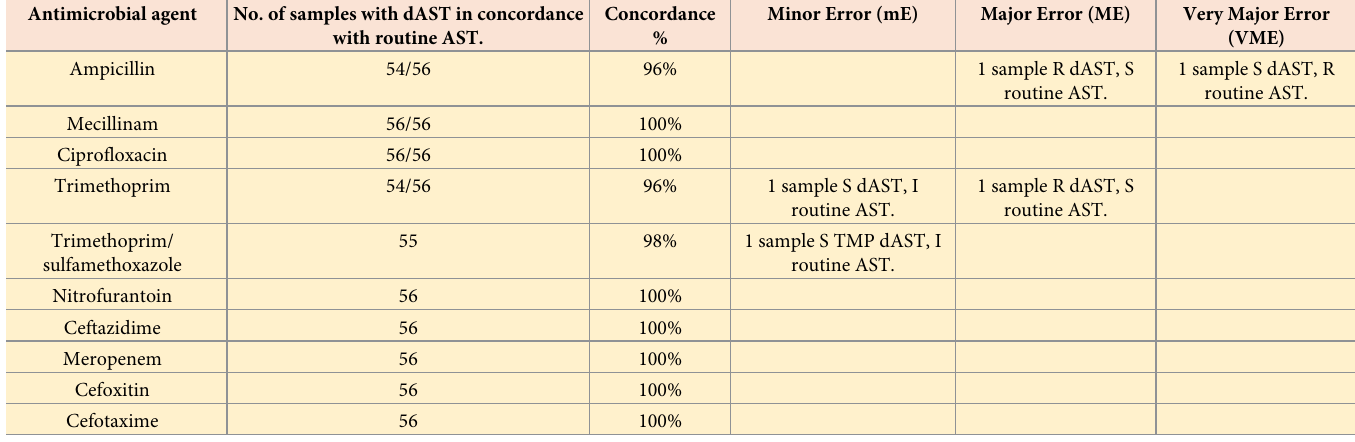
Table 7. Discrepancy of antibiotic susceptibility comparing routine AST to dAST. Antimicrobial agent No. of samples with dAST in concordance with routine